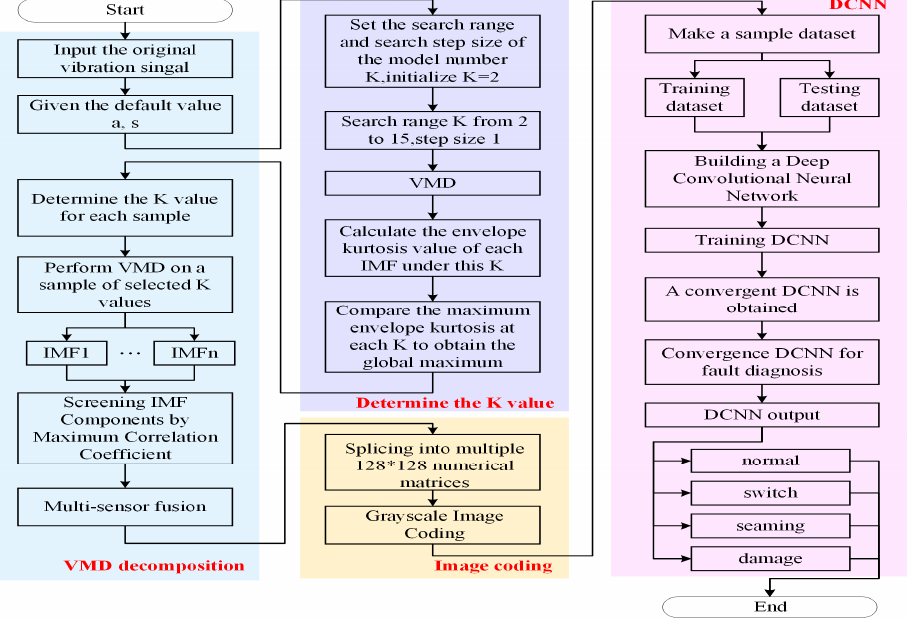
Figure 1. Overall algorithm flow chart.